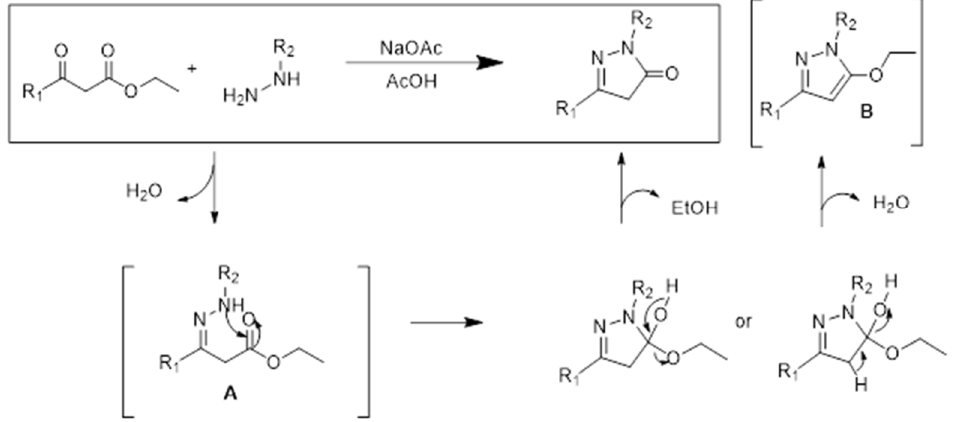
Figure 3. Reaction mechanism leading to the formation of the targeted pyrazolone compound together with an inactive ethoxy-pyrazole derivative. Traces of intermediates A and B can be detected by LC-MS analysis, but they were not isolated further.